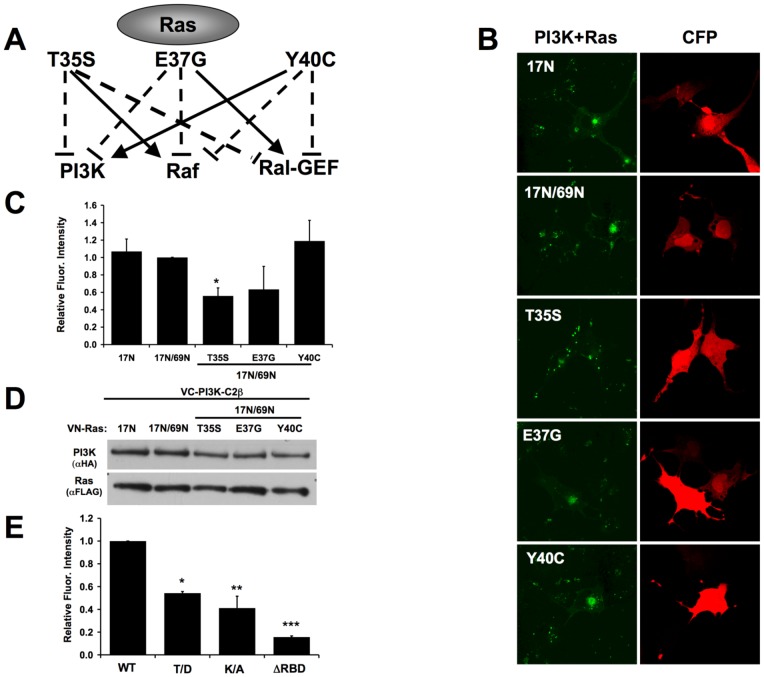
Mutations in the effector region of Ras disrupt PI3KC2β binding.(A) Point mutations in the effector region of Ras12V disrupt interactions with specific Ras targets. (B) VC-tagged PI3KC2β was co-transfected with either VN-tagged Ras17N, 17N/69N, or one the effector mutants in the background of Ras17N/69N. BiFC signal is pseudo-colored green. Effector mutations that disrupt Class I PI3K binding to Ras12V disrupt Class II PI3K binding to Ras17N/69N. CFP (red) was used as a transfection control. (C) Graph represents the average fluorescence intensity per cell ± S.E.M. from at least three independent experiments. (*p = 0.02). (D) Western blot analysis demonstrates equal expression of all constructs. (E) Mutation of Thr392 to Asp or Lys379 to Ala in full-length PI3KC2β disrupts interaction with Ras17N. The ΔRBD mutant was also included as a negative control. Graph represents the average of three independent experiments (*p<0.05).